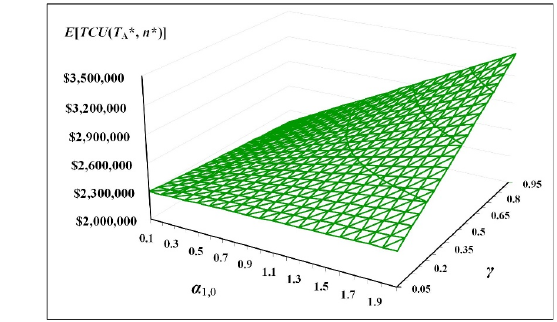
Fig. 9. Behavior of E [ TCU ( T A *, n *)] regarding α 2,0 and α 3,0 Fig. 10. Combined impact of α 1,0 and γ on E [ TCU ( T A *, n